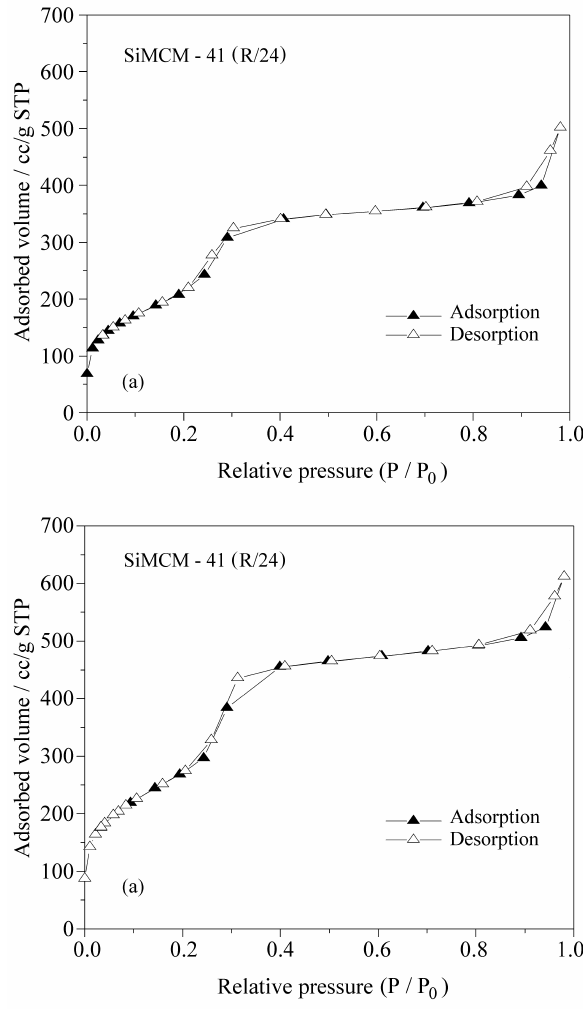
Figure 2. Adsorption/desorption isotherms of N 2 for calcined SiMCM-41 samples.